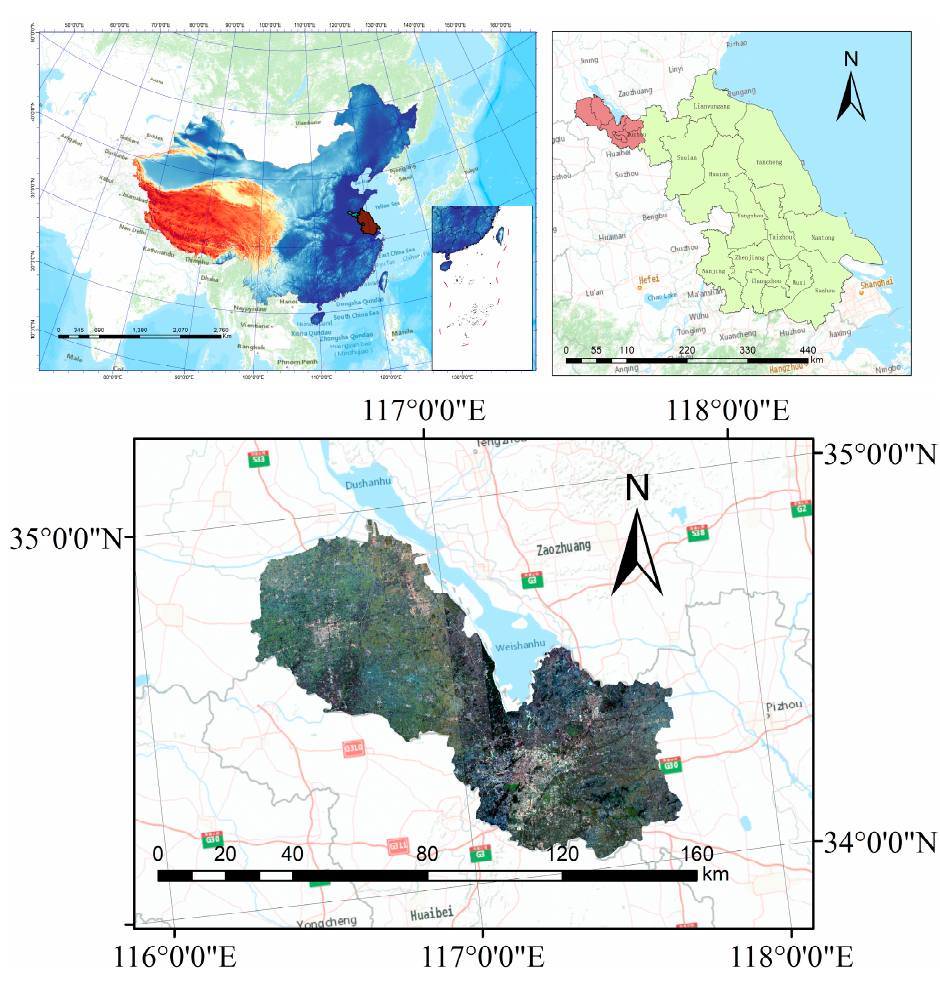
Figure 1. Location of the study area.